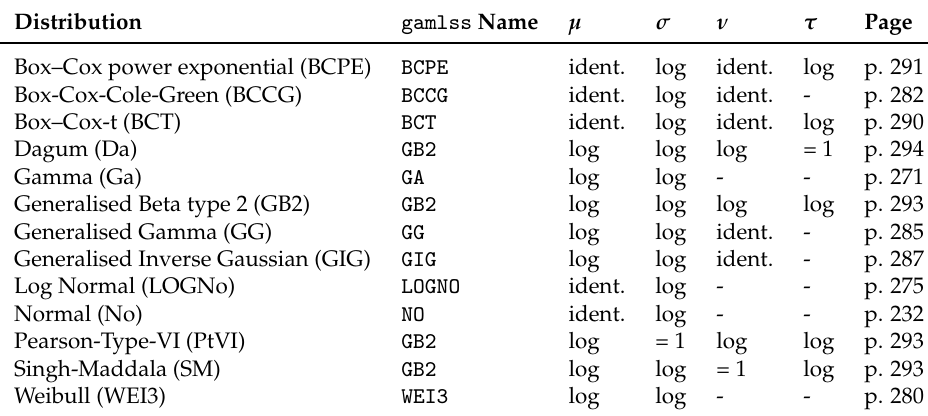
Table A1. Distributions used for the